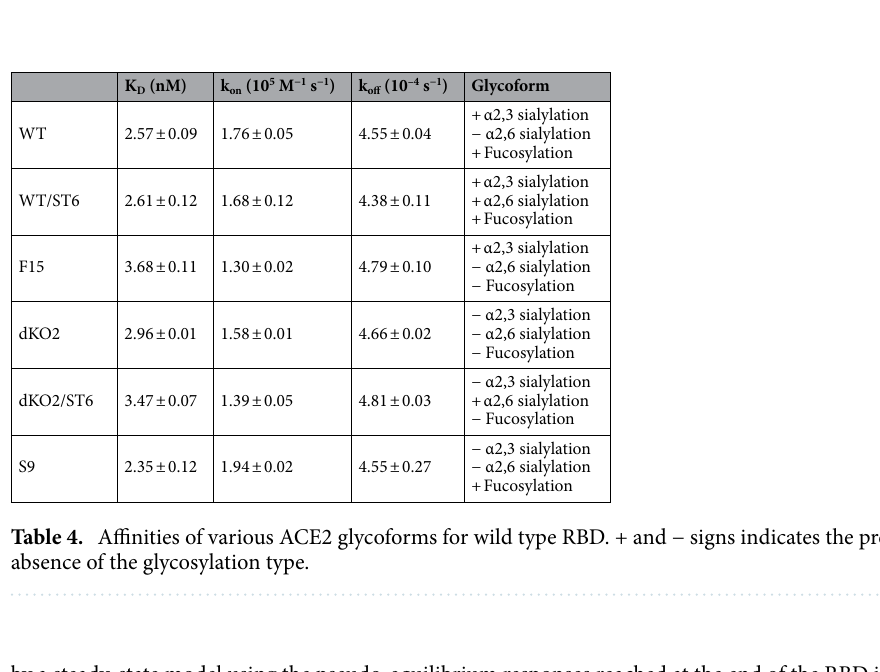
Table 3. Thermodynamic evaluation of the interaction of RBD variants with ACE2. *Indicates kinetic constants that were calculated using a steady-state model.